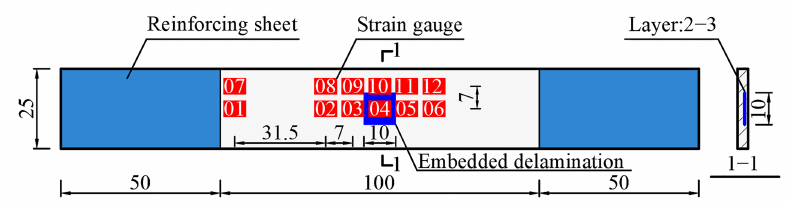
Figure 1. Parameter information of the laminate sample (Unit: mm).